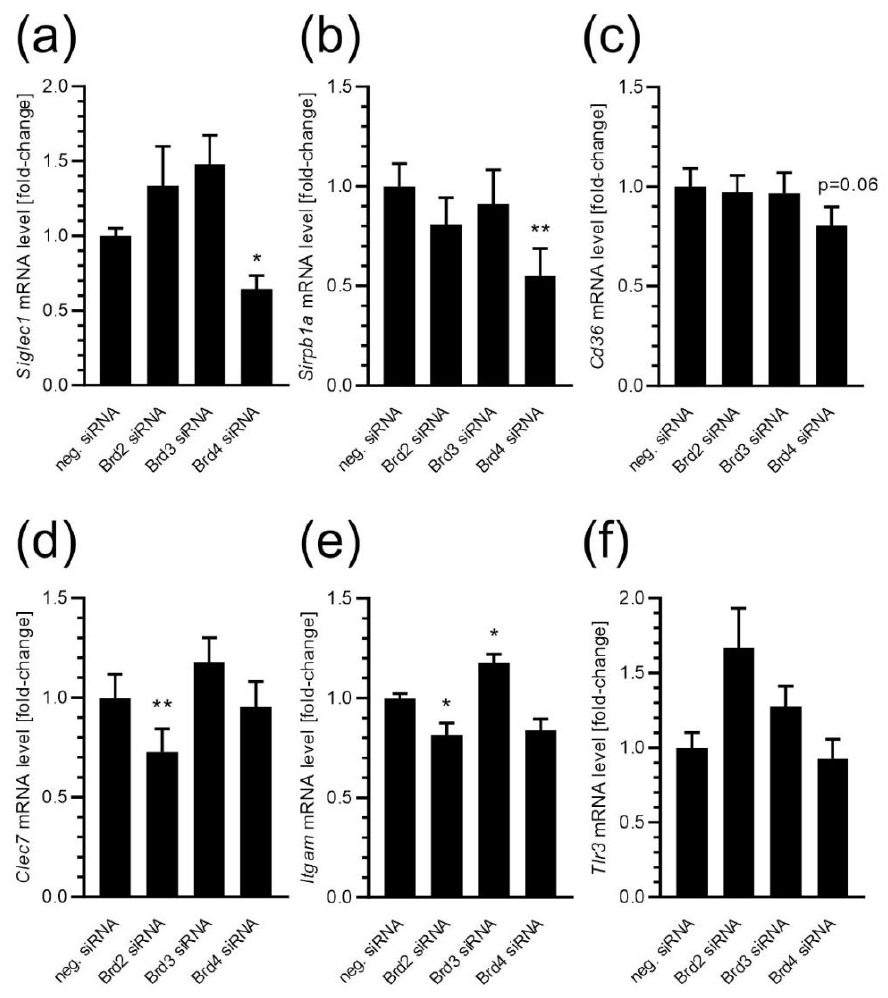
Figure 7. The effect of BET silencing on the microglial expression of phagocytosis-related genes in BV2 cells. The mRNA levels for Siglec1 ( a ), Sirpb1a ( b ), Cd36 ( c ), Clec7a ( d ), Itgam ( e ), and Tlr3 ( f ) were determined 24 h after gene silencing by using the qPCR method. Means ± SEM are presented. n = 8; * p < 0.05, ** p < 0.01, compared to the negative siRNA-treated group. Statistical analysis was performed by using a one-way ANOVA followed by the Bonferroni post hoc test.